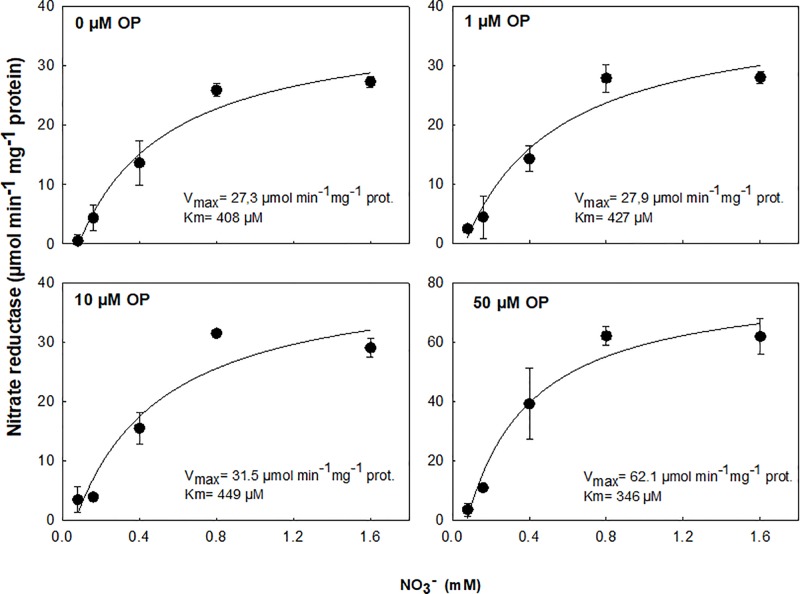

In vitro activity assay of purified NADH-Nitrate Reductase (NR) from Arabidopsis thaliana in cell-free extracts with 0.08, 0.16, 0.4, 0.8, and 1.6 mM NO3
- and 0, 1, 10, or 50 µM omeprazole (OP). Data are means ± s.d. (shown by vertical bars when larger than the symbol); n = 3 from independent experiments. Lines were fitted by linear regression.